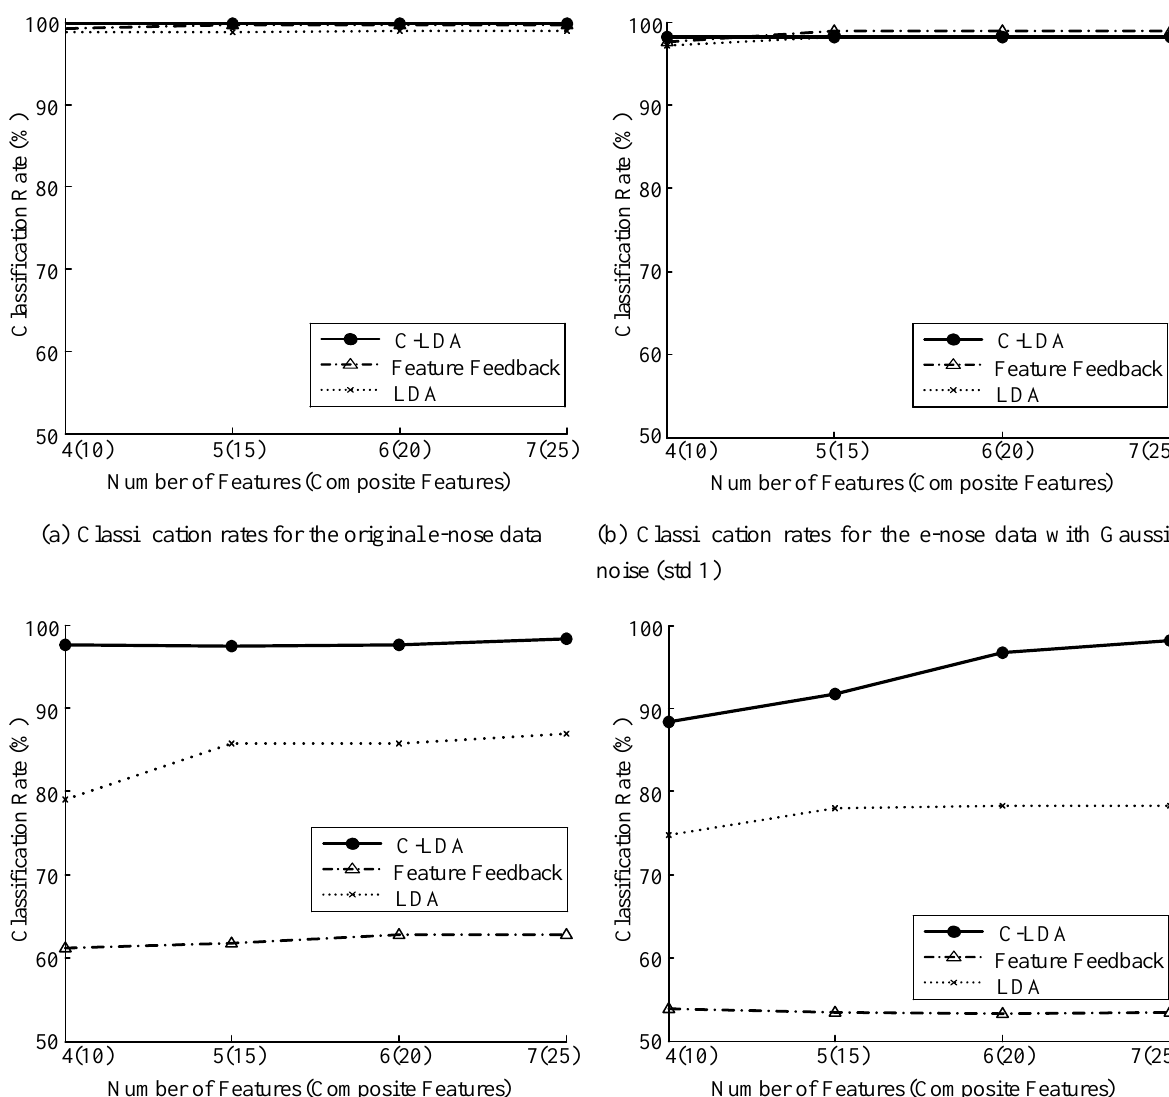
Figure 7. Classification rates for the e-nose data.